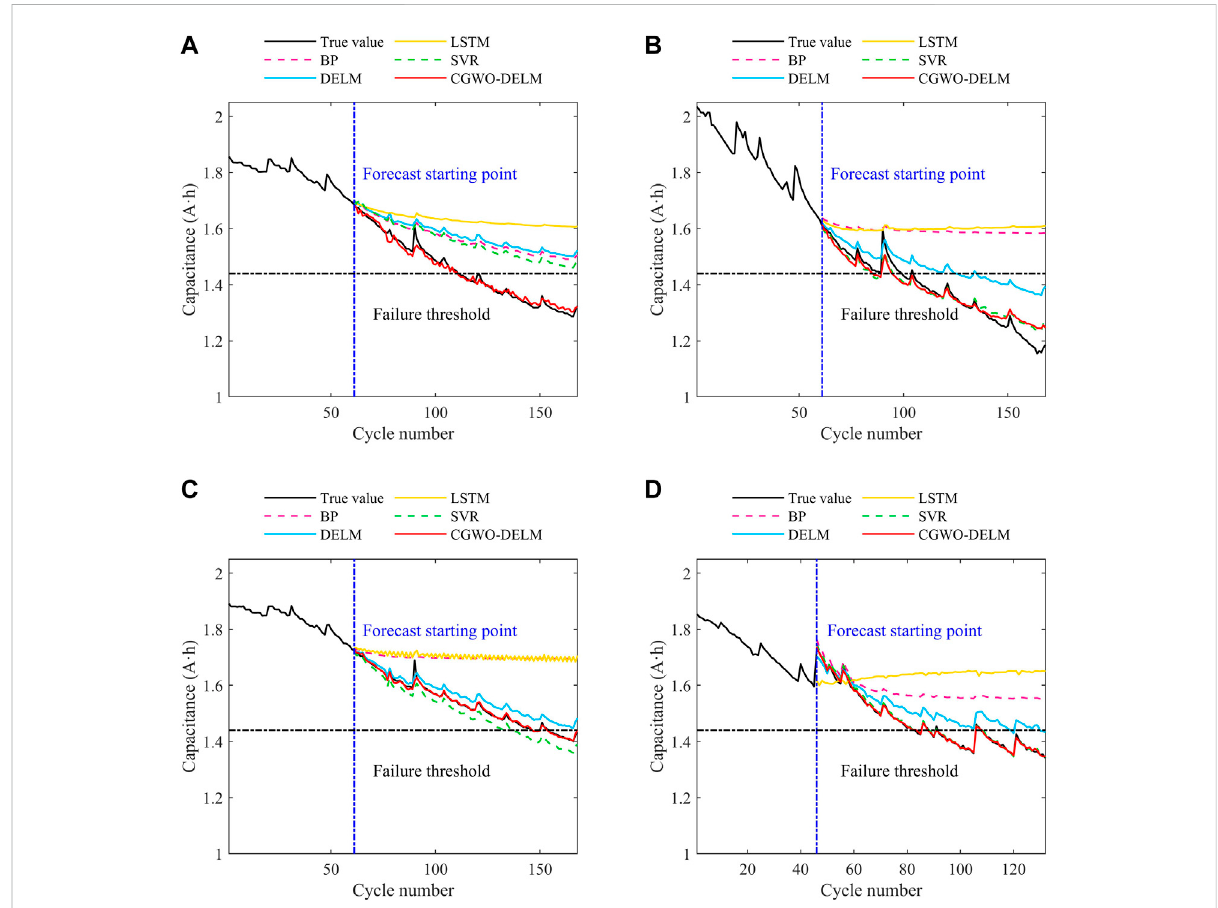
FIGURE 8 RUL prediction results of lithium-ion battery by CGWO-DELM and four other prediction methods (the fi rst 60 cycles of data are used as the training set). (A) Battery B0005. (B) Battery B0006. (C) Battery B0007. (D) Battery